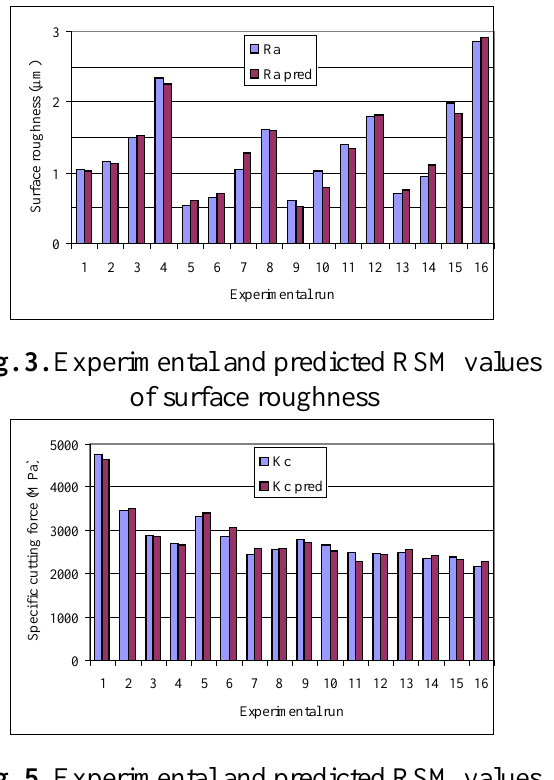
Fig. 6. Experimental and predicted RSM values of cutting power